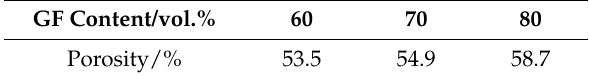
Table 3. Porosity of the SLS-sintered GF/PF green parts with different GF content. GF Content/vol.%